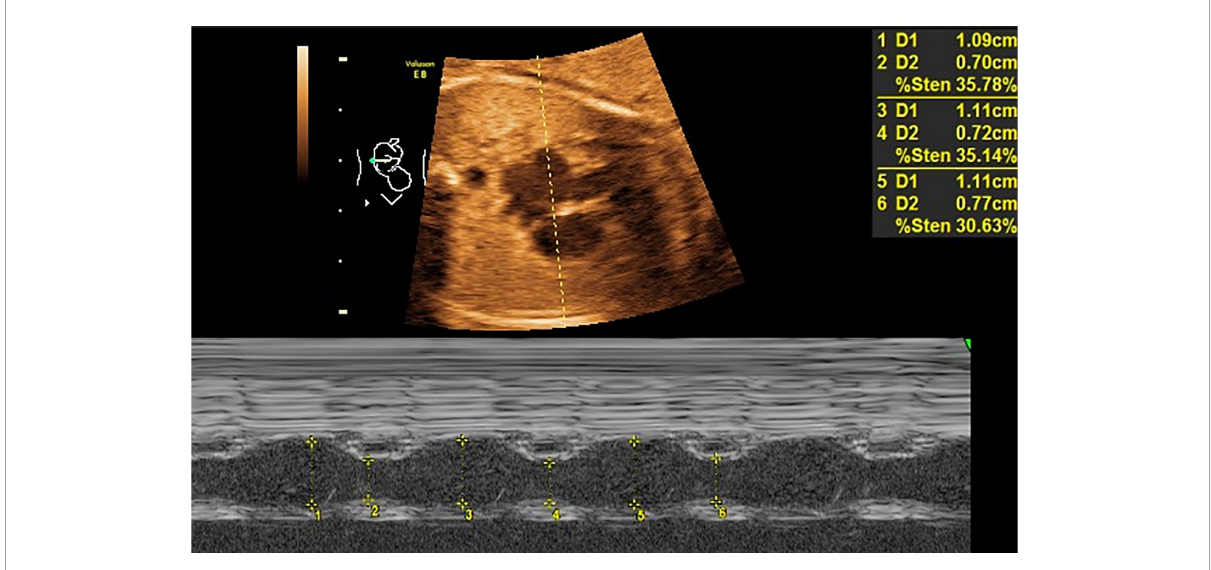
FIGURE1 LASF in GDM fetuses at gestational age 26 weeks + 3 days. LASF, left atrial shortening fraction; GDM, gestational diabetes